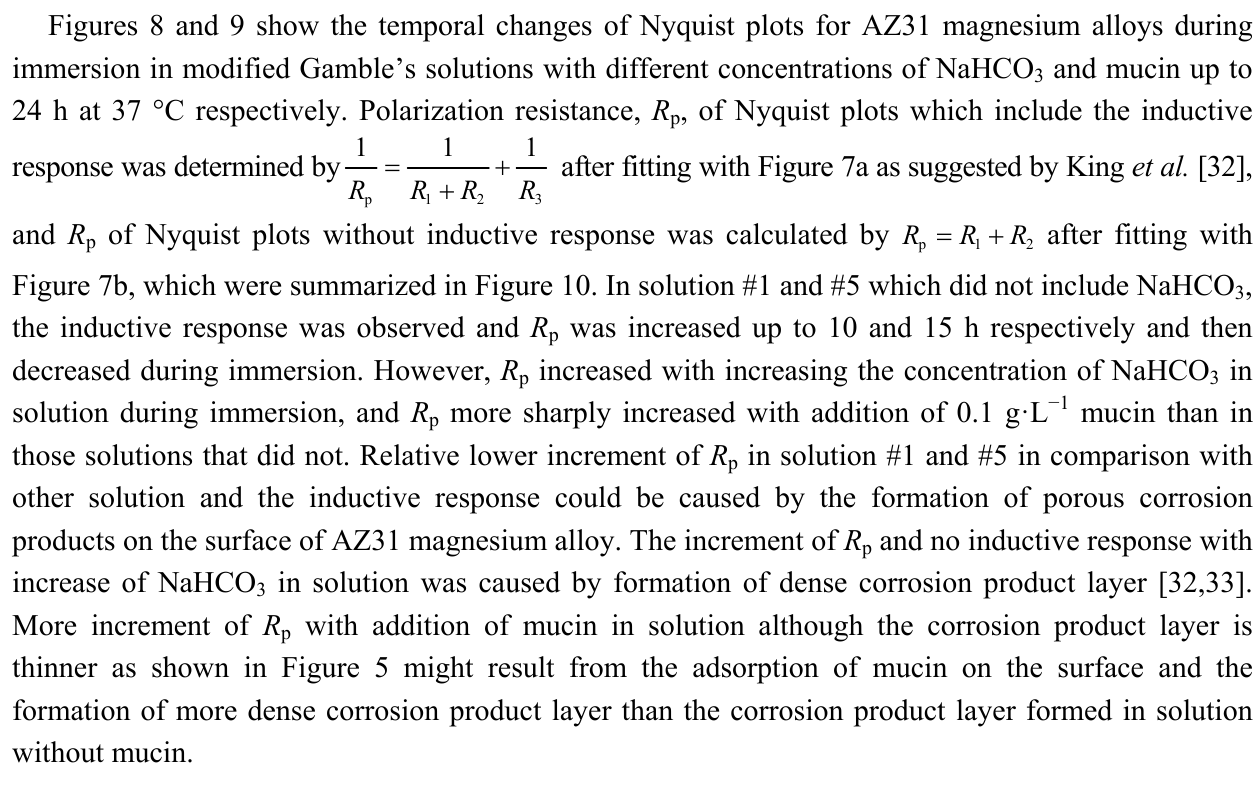
Figure 8. Change of Nyquist plot for AZ31 magnesium alloys in modified Gamble’s solutions with different concentrations of NaHCO